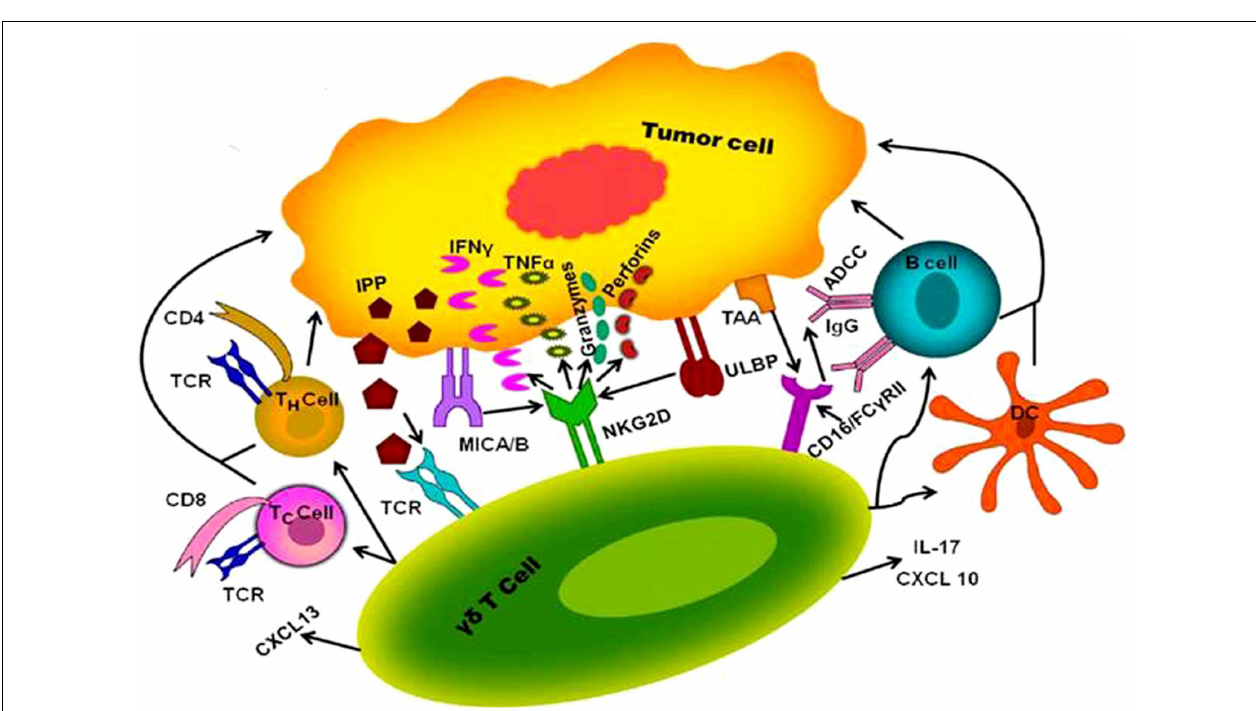
chemokines such as IFN- γ ,TNF- α , IL-2, IL-17, perforin, grazymes, CXCL-10, and CXCL-13, which can directly lyse the tumor cell and can recruit other immune cells likeT cells (T H cells andT C cells), B cells, and dendritic cells (DC) to aid killing of tumors. γδ T cells expressing CD16 receptor (FC γ RIII) interacts with TAA mediate ADCC through activation of B